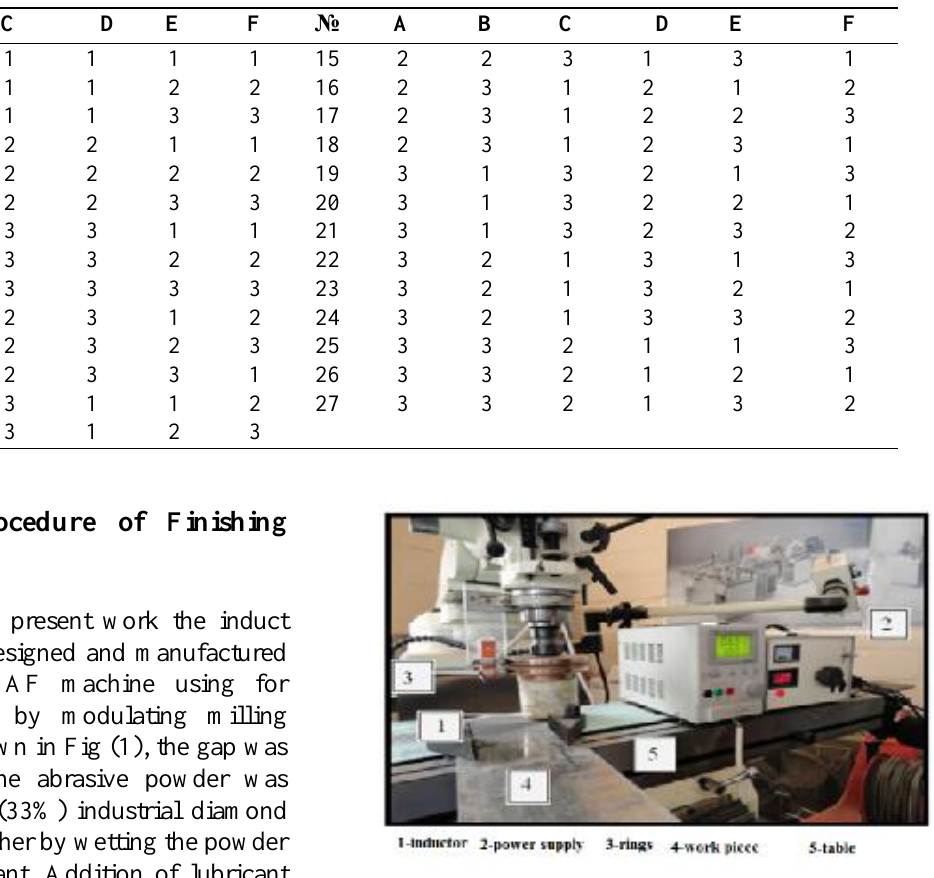
Orthogonal Array(OA)L27